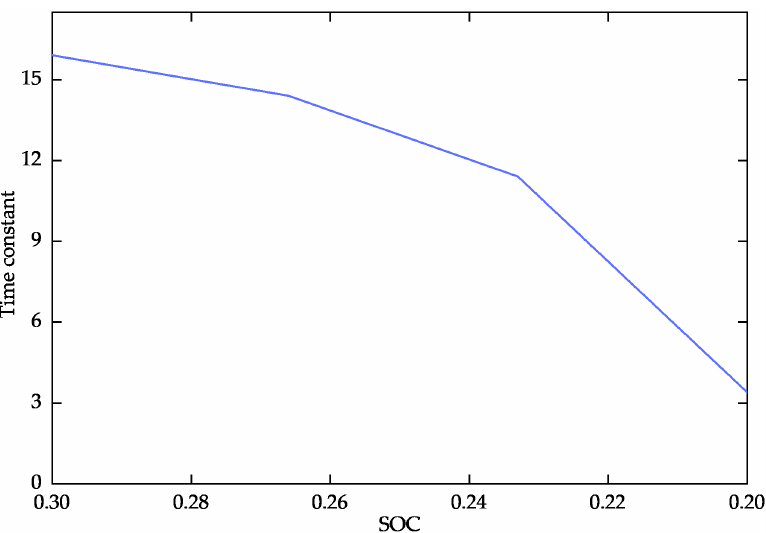
Figure 8. The slope change of the filter time constant update.